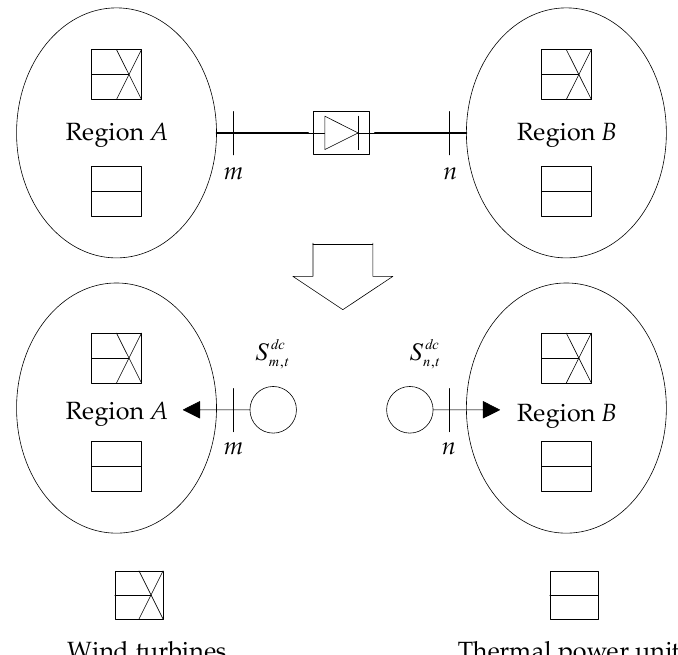
Figure 1. The principle of region decomposition.